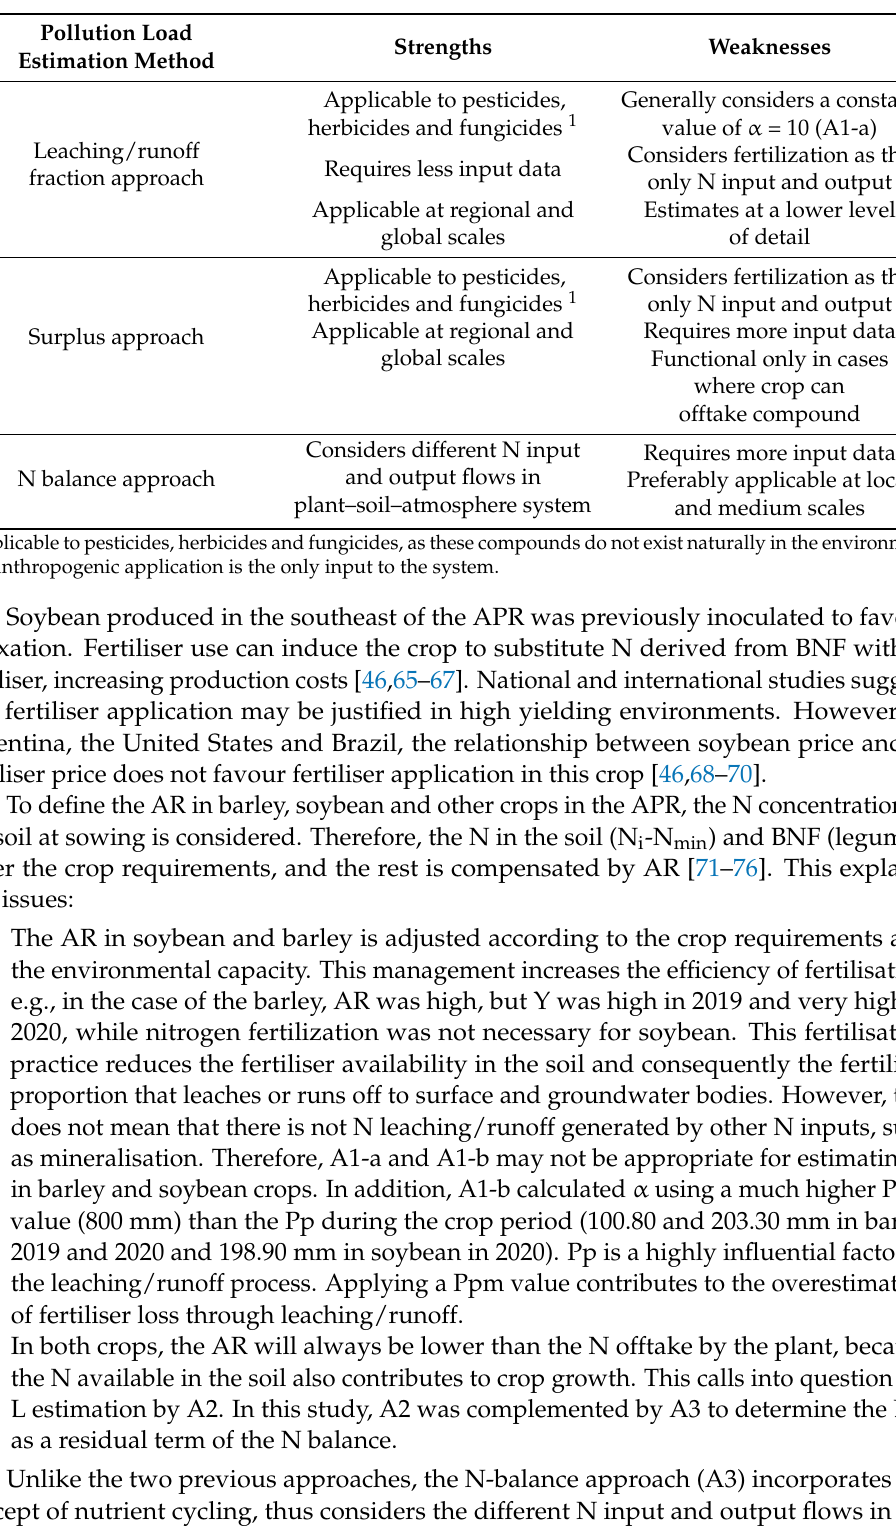
Table 4. Strengths and weaknesses of three grey water footprint assessment methods analysed: leaching/runoff fraction, surplus and the balance